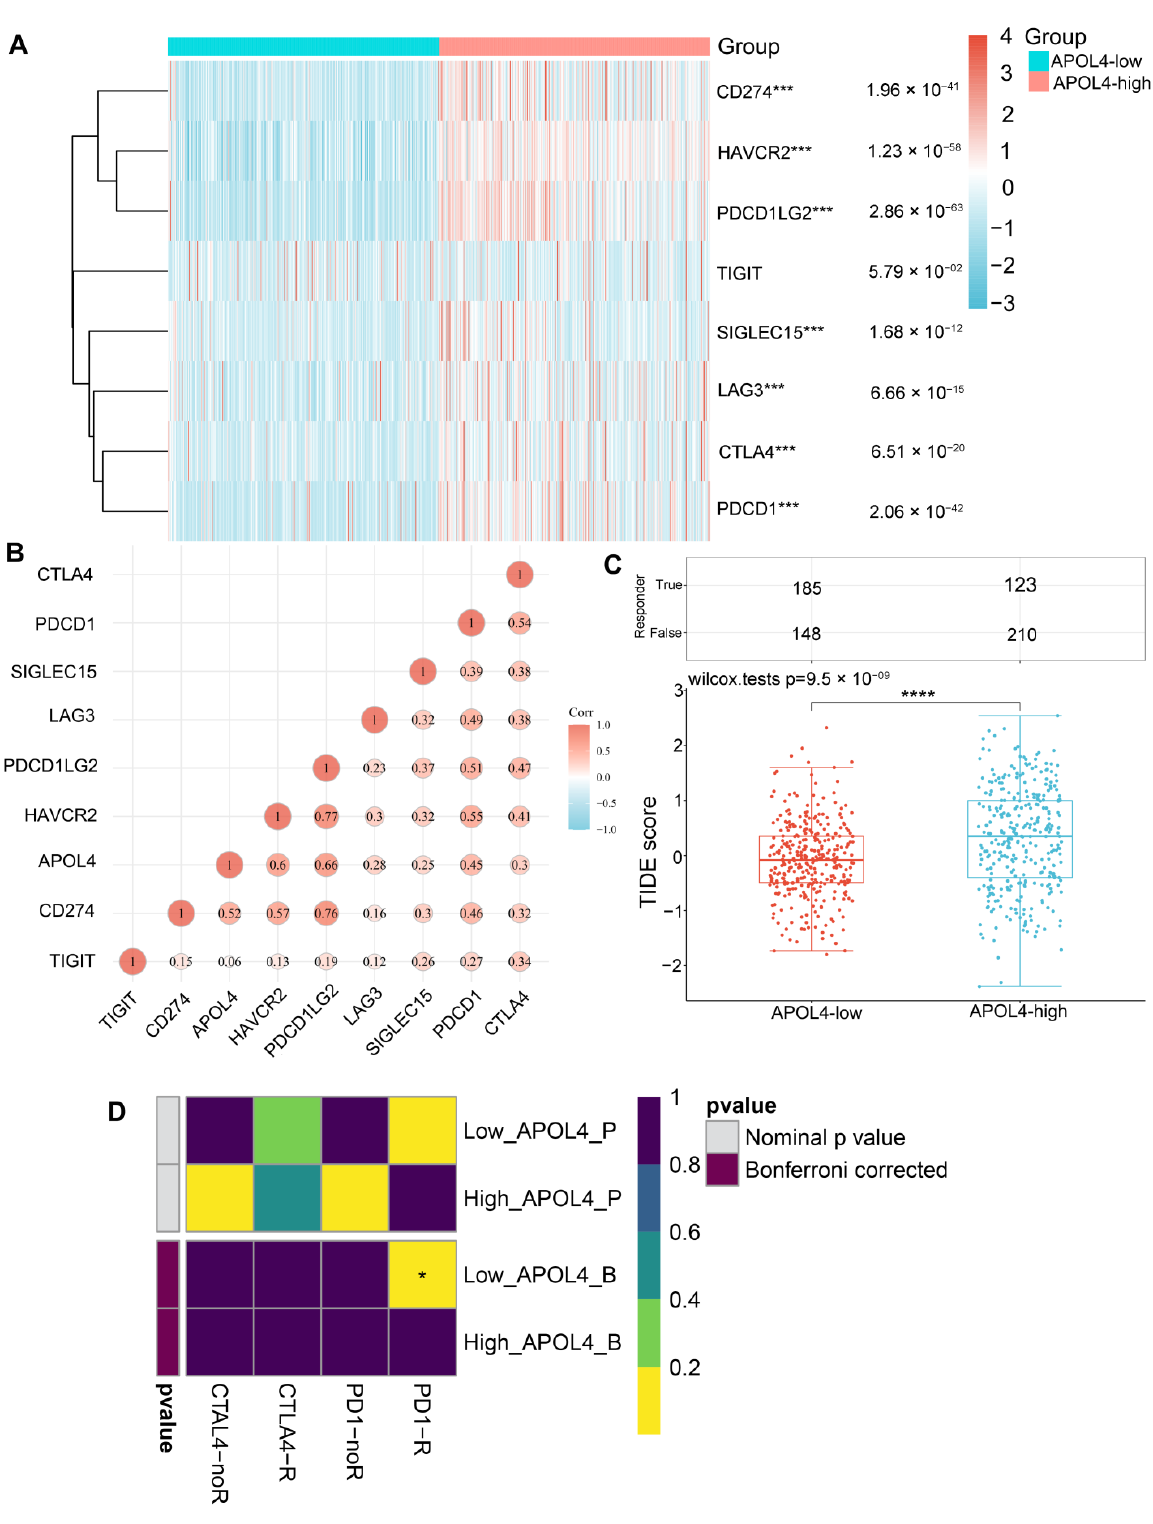
Figure 5. The relationship of APOL4 expression with immune checkpoints and the response to ICI in gliomas. ( A ) The expression of immune checkpoints in the APOL4-high and APOL4-low groups of gliomas. ( B ) The correlation of APOL4 with immune checkpoints. ( C ) TIDE scores in the APOL4-high and APOL4-low groups. ( D ) Submap analysis manifested that APOL4-low could be more sensitive to the PD1 inhibitor. * p < 0.05, *** p < 0.001, and **** p <